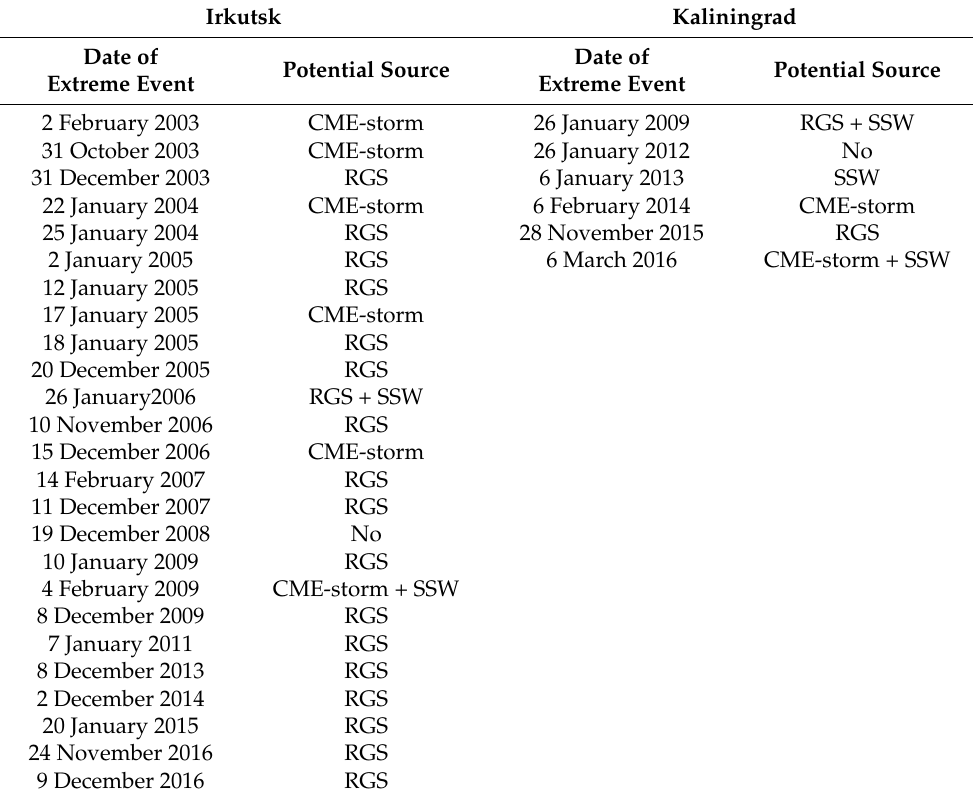
Table 1. List of extreme ionospheric events and their potential sources for Irkutsk (2003–2016) and Kaliningrad (2009–2016)